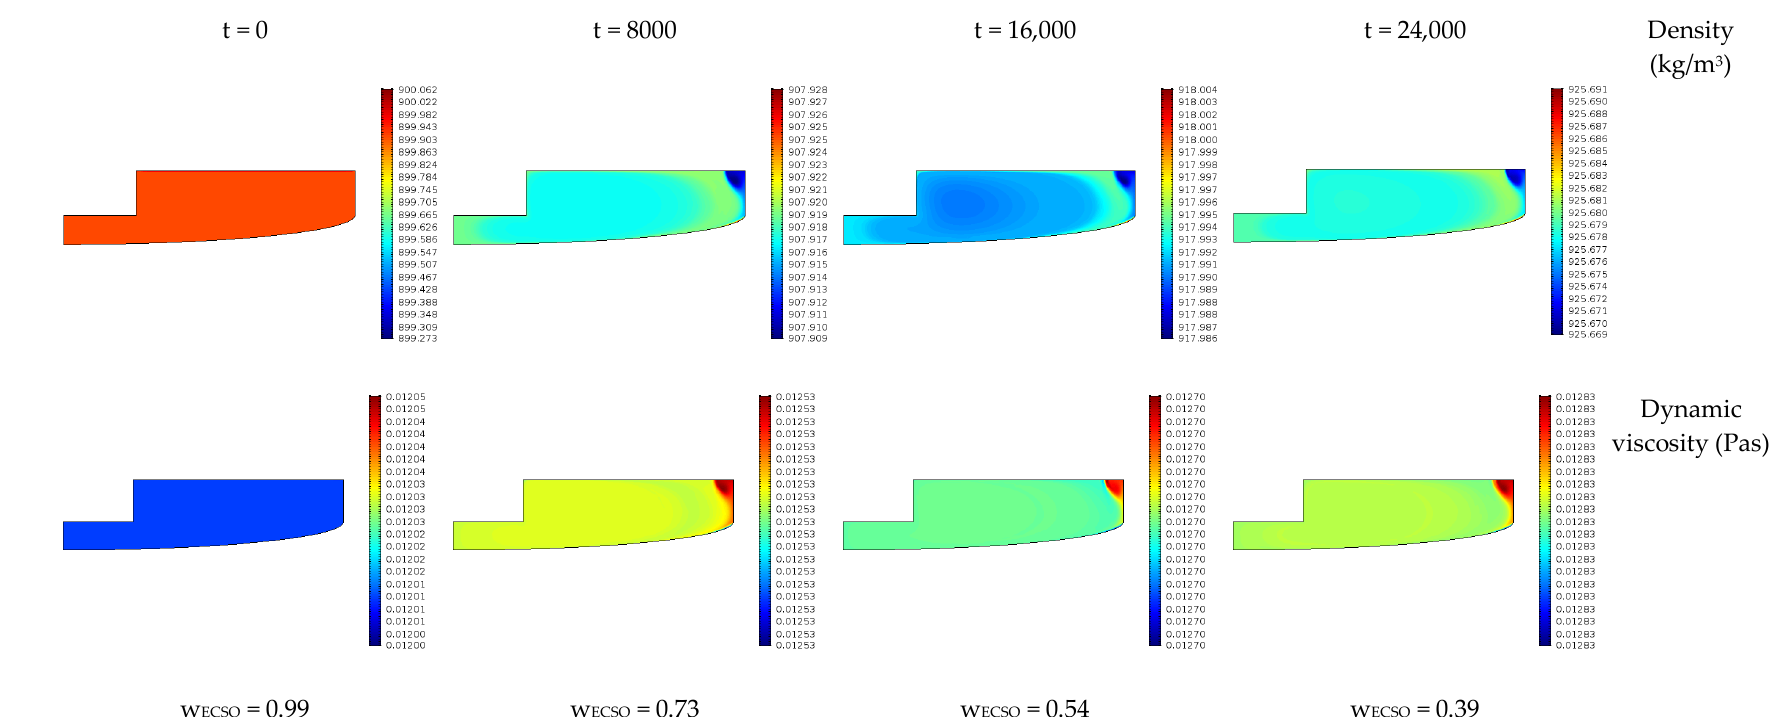
Figure 8. The changes of viscosity and density in time for experiment 1 (and consequently ECSO concentration).